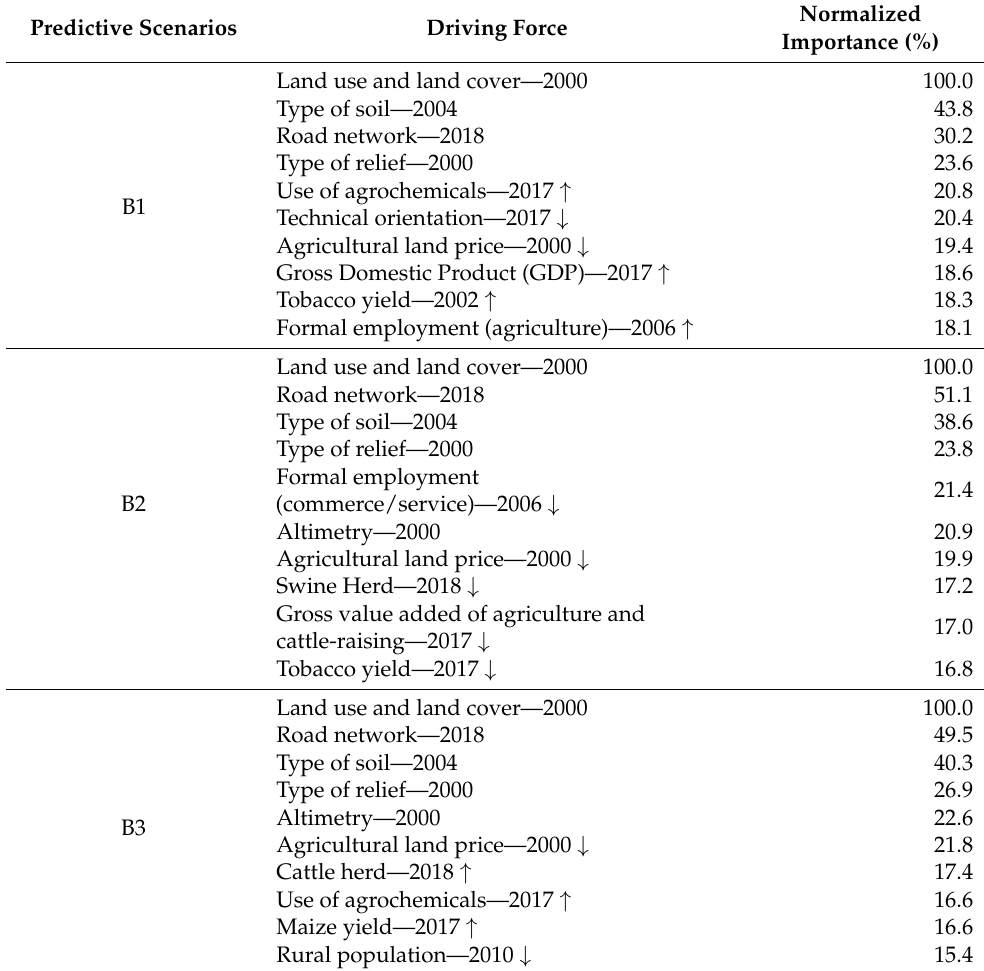
Table 12. The ten most important driving forces in predictive scenarios B.